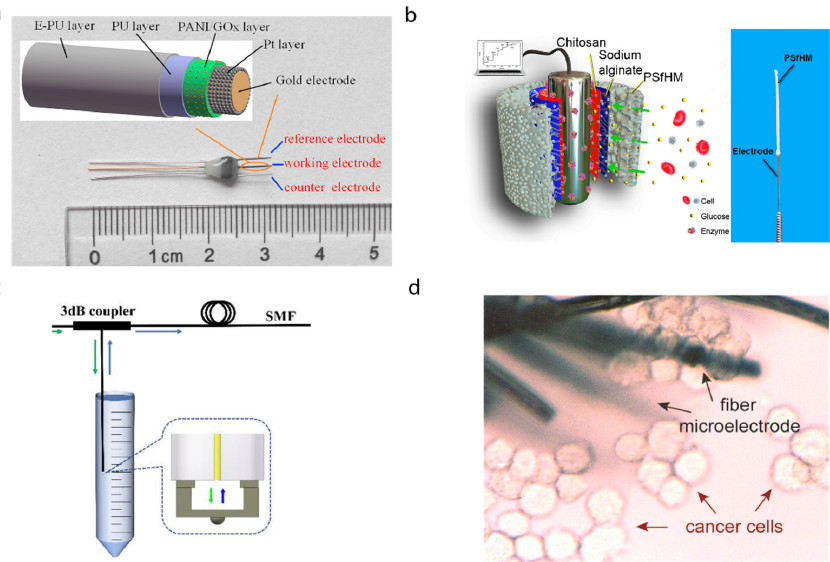
Figure 8. Probes for in vivo biomarkers sensing. ( a ) A needle-type blood glucose biosensor for long-term in vivo monitoring. Reprinted with permission from Ref. [29]. Copyright 2017, Elsevier. ( b ) Implantable glucose biosensing probe. Reprinted with permission from Ref. [30]. Copyright